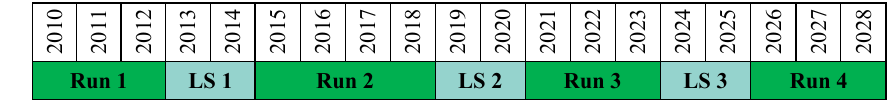
Table 1. LHC cycle by